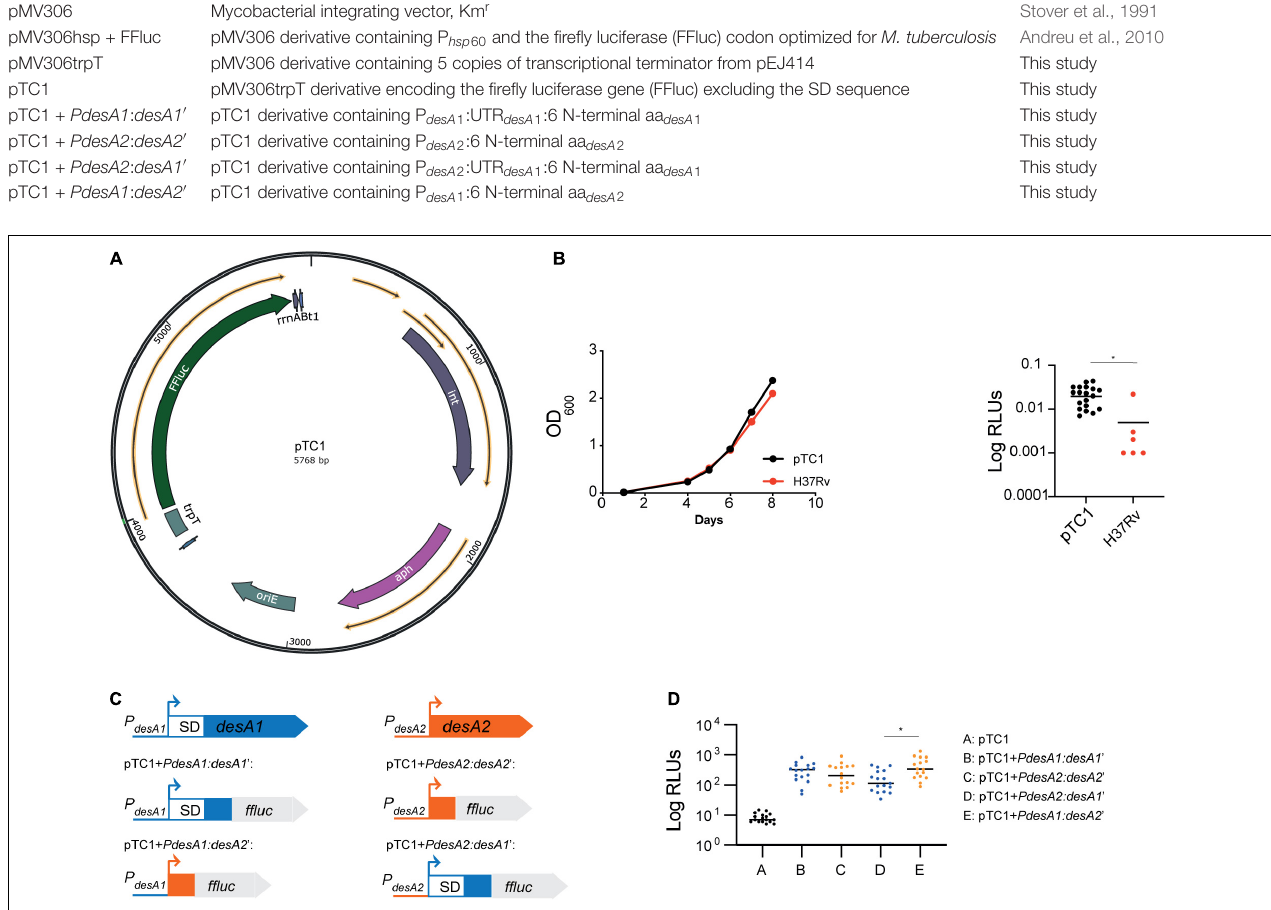
FIGURE 1 | Construction of leaderless and Shine–Dalgarno luminescent reporter strains in M. tuberculosis . (A) Circular map of plasmid pTC1 [pMV306trpT-FFluc( del SD)]. The transcriptional terminator and firefly luciferase gene are designated as trpT and FFluc respectively. For construction of downstream plasmids, the required regulatory regions were cloned between these two regions. Circular map was generated with the SnapGene Software (from